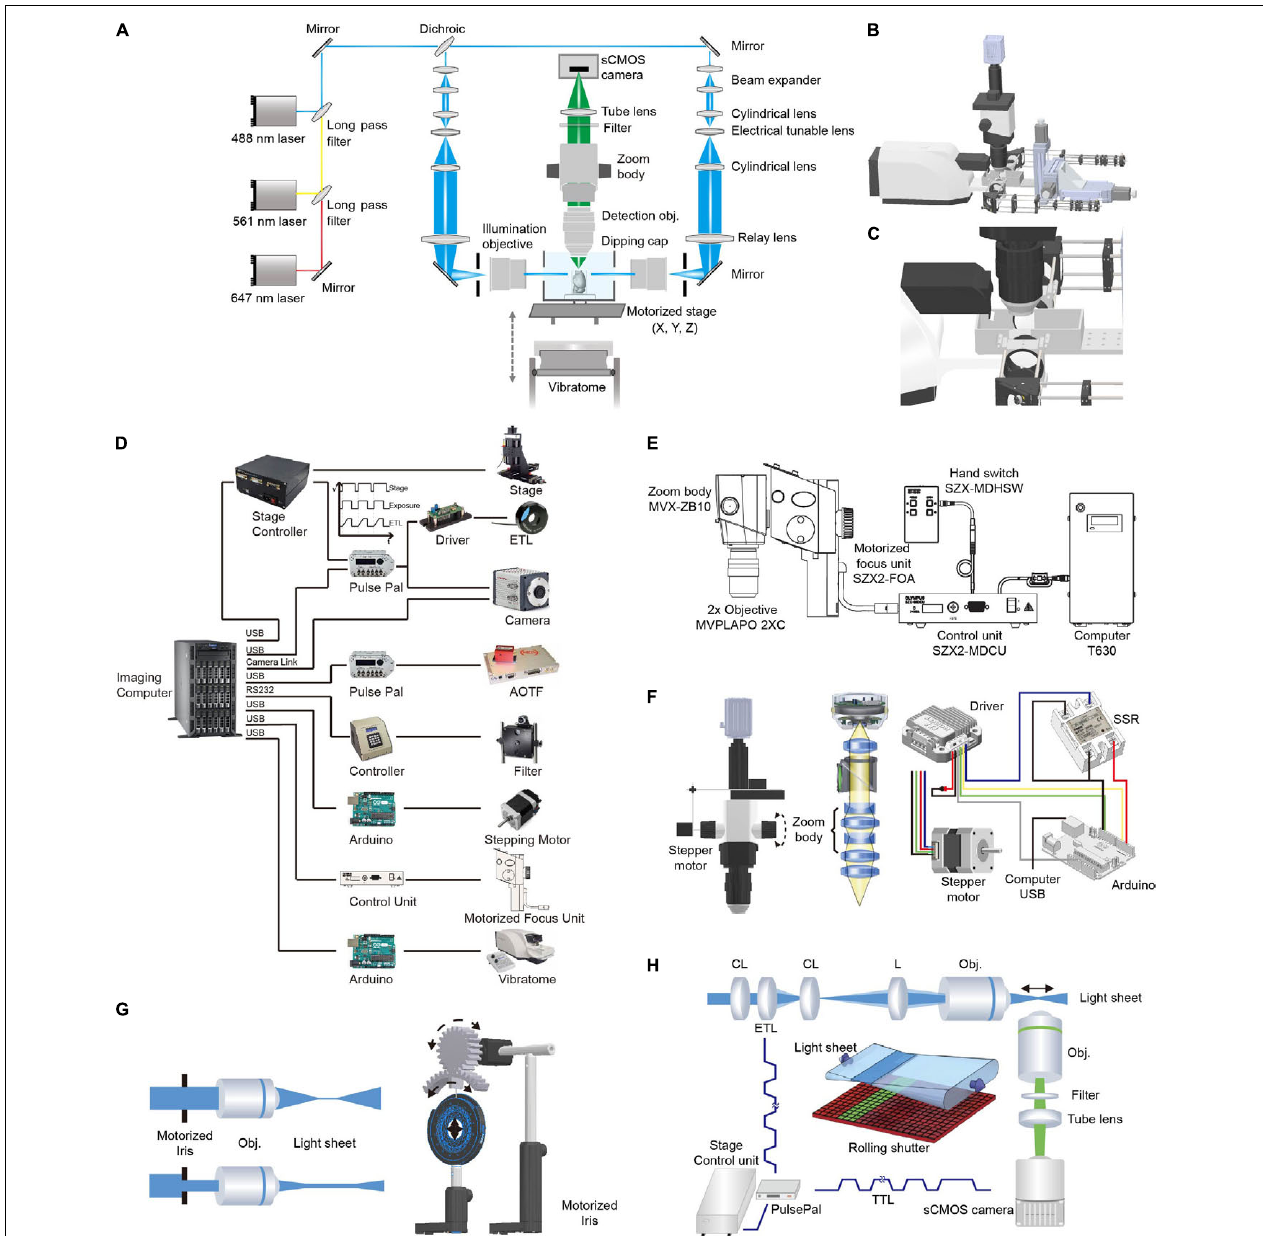
FIGURE 2 | Optical layout and hardware control in multi-scale LSFM. (A) Optical layout of the customized LSFM. (B) Inventor three-dimensional (3D) rendering of the customized LSFM. (C) Zoomed-in view of the imaging chamber, detection objective, illumination objectives, and the vibratome. The detection objective, Olympus MVPLAPO 2X, has an NA of 0.5 and a working distance (WD) of 20 mm. As the detection objective is an air objective and the imaging media, such as benzyl alcohol-benzyl benzoate (BABB), has a refractive index of 1.56, a 3D-printed dipping cap was attached to the objective to reduce spherical aberration. The two illumination objectives, Olympus MVPLAPO 1X, have an NA of 0.25 and a WD of 65 mm that leaves enough space for the imaging chamber. (D) Hardware control diagram. Mechanical stages, AOTF (shutter and laser intensity control), filter wheel, stepping motor, motorized focus unit, and vibratome are directly controlled with a computer through their controllers. To synchronize the electrically tunable lens (ETL) with virtual slit detection, the Z-stage at specified positions sends out a transistor–transistor logic (TTL) signal to trigger camera exposure and ETL focus. (E) Adjustment of objective focus. The motorized unit (SZX2-FOA; Olympus, Tokyo, Japan) with a control unit (SZX2-MDCU) was used to refocus between different zoom settings, as there is a small focus difference at different zoom magnifications. (F) Adjustment of magnification. A stepper motor (UI robot) was attached to the shaft of the magnification knob to automatically adjust magnification. The stepper motor was computer-controlled via its driver and an Arduino board (UNO). An solid state relay (SSR) was used to switch between the manual and automatic adjustments of magnification. (G) Light-sheet thickness was adjusted using a motorized iris to trim the beam diameter entering the illumination objective. The motorized iris was customized by attaching a stepper motor (UI robot) to an iris (ID50/M; Thorlabs, Newton, NJ, United States) through a pair of three dimensional (3D)-printed gears. (H) Synchronization between ETL focus and camera exposure during non-stop Z scanning. The customized linear stage continuously moves along the Z axis and sends out a TTL signal every 2 µ m to synchronize ETL focus and camera exposure.